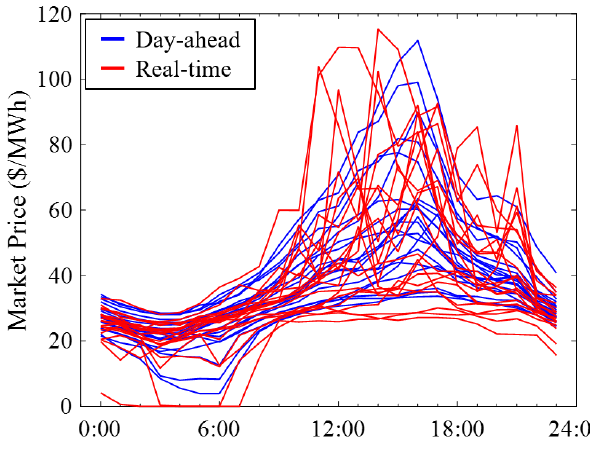
Figure 4. Example of scenarios of market